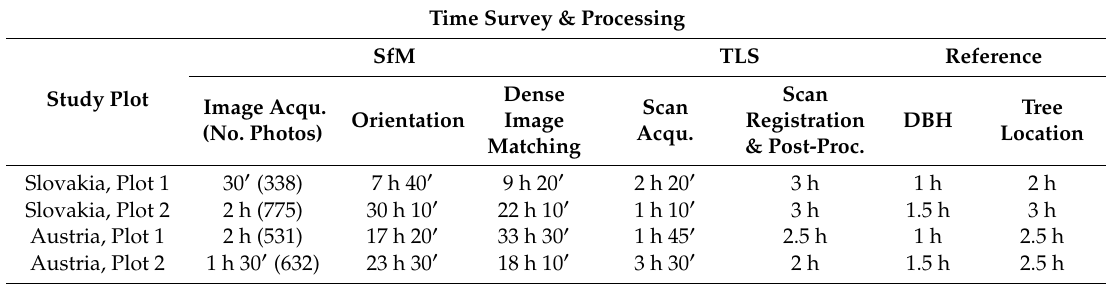
Table 7. Approximate times needed for data acquisition and processing for each survey